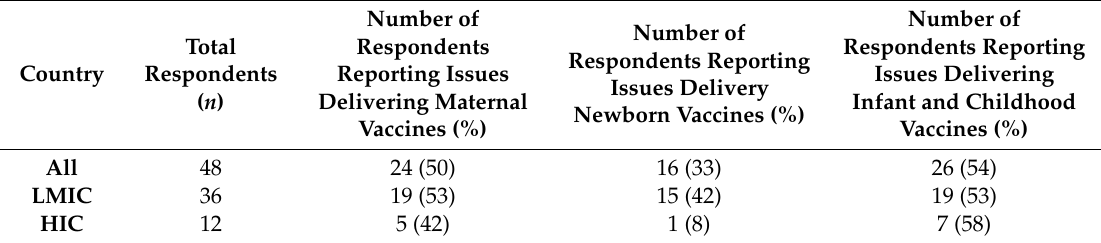
Table 2. Number of respondents who reported issues in delivering maternal, newborn and infant / childhood